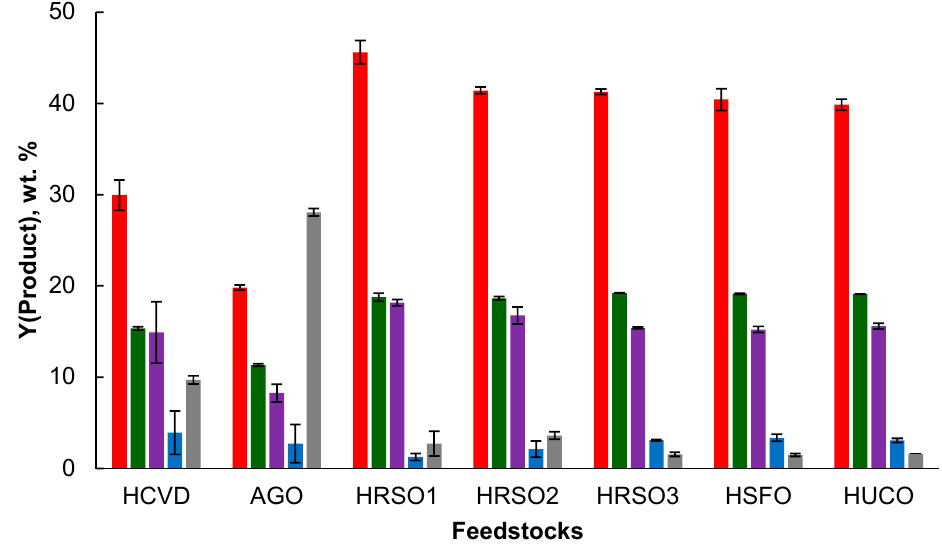
Figure 1. Yields of main pyrolysis products: ■ ethylene, ■ propylene, ■ C4 fraction, ■ benzene and